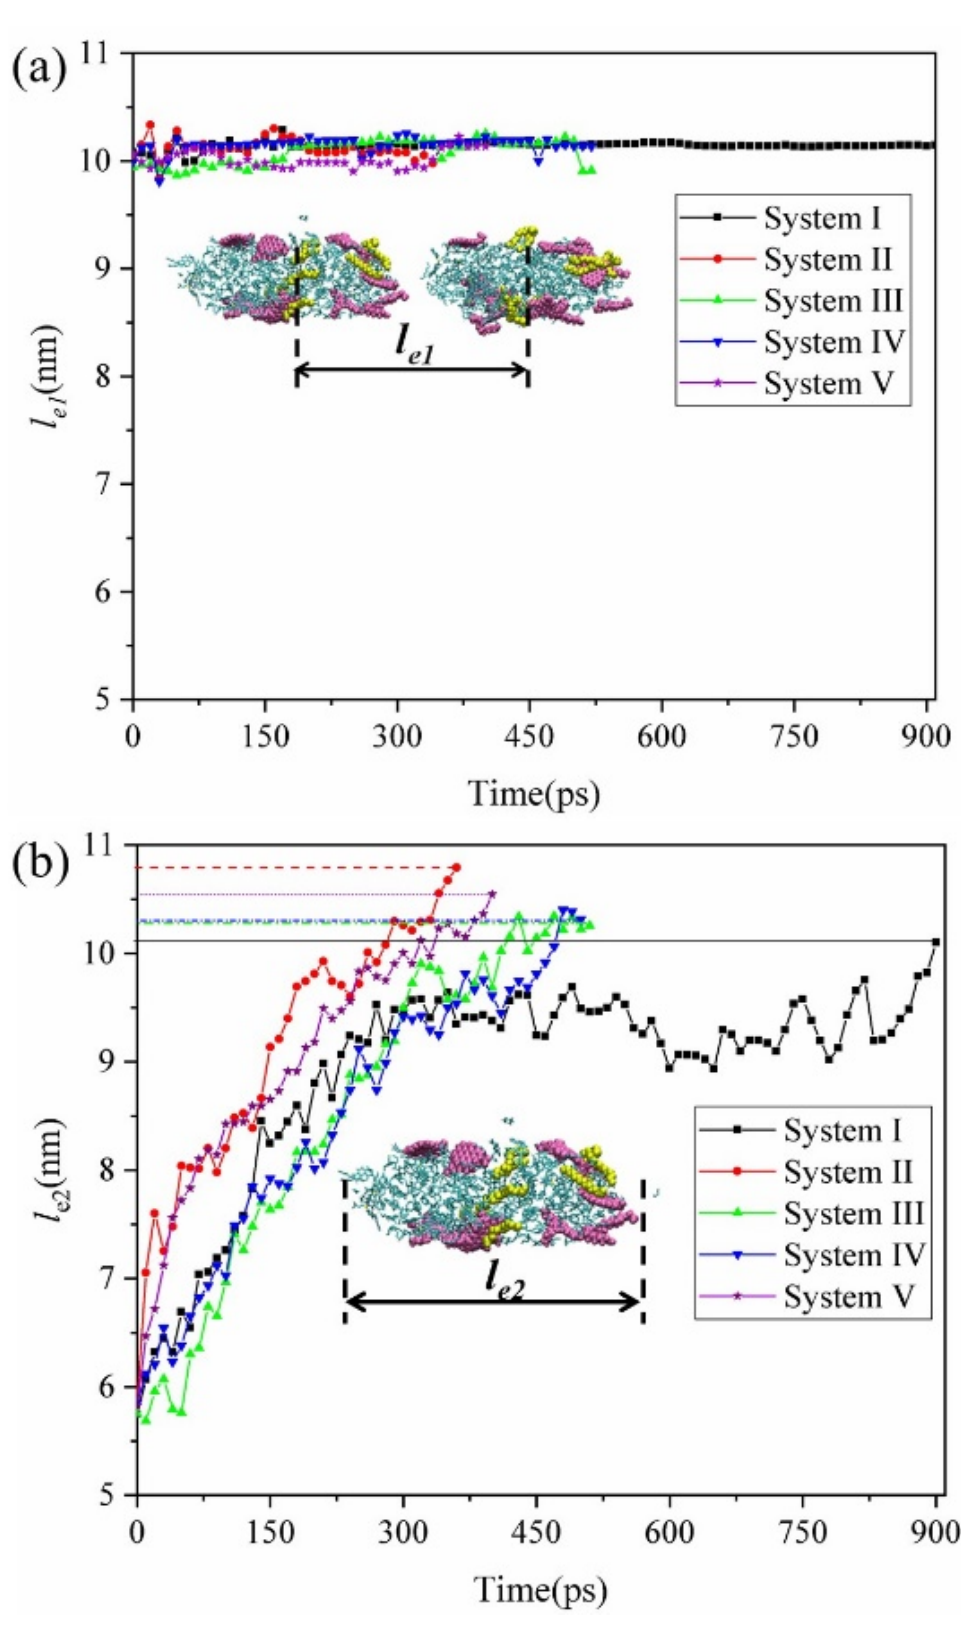
Figure 6. Centroid distance between two oil droplets ( a ) and average elongation length le of the two oil droplets along the z direction ( b ).